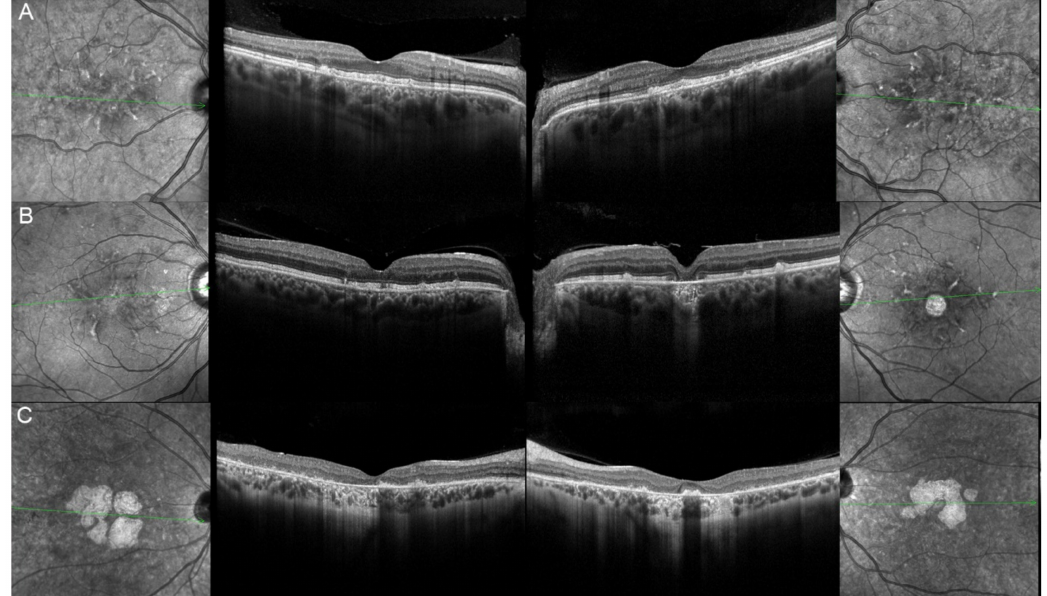
Figure 12. Optical coherence tomography (OCT) of patients harboring the pathogenic c.422A>G p.(Tyr141Cys) PRPH2 variant. Patient 17/II.1 ( A ), patient 18/II.2 ( B ), patient 19/III.2 ( C ). For each patient, green lines on FAF images indicate the scanning sections (left and right panels) of the OCT (middle panels). The left panels show the right eye, and the right panels the left one. The OCT findings are described in detail in Table